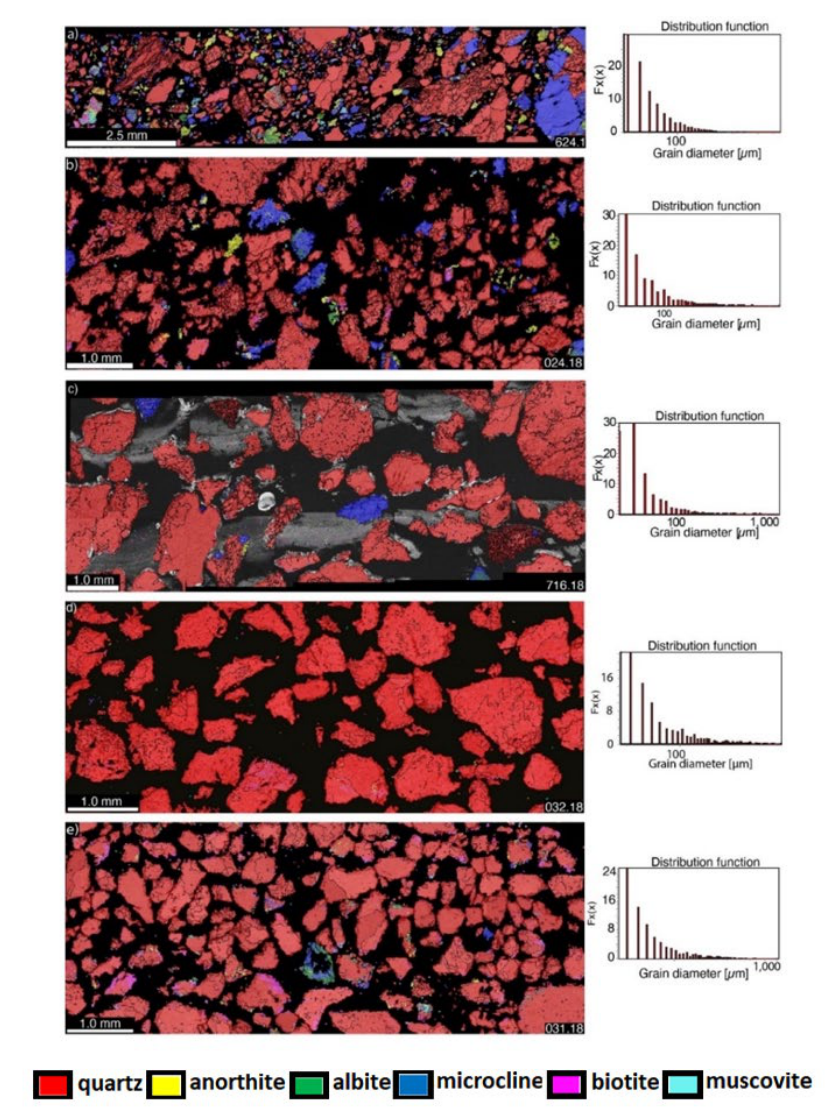
Figure 3. FEG-SEM/EBSD micro graphic ima ges representing the mineral phase maps of the natural sand samples, tested for ASR expansion, and the histograms of each distribution